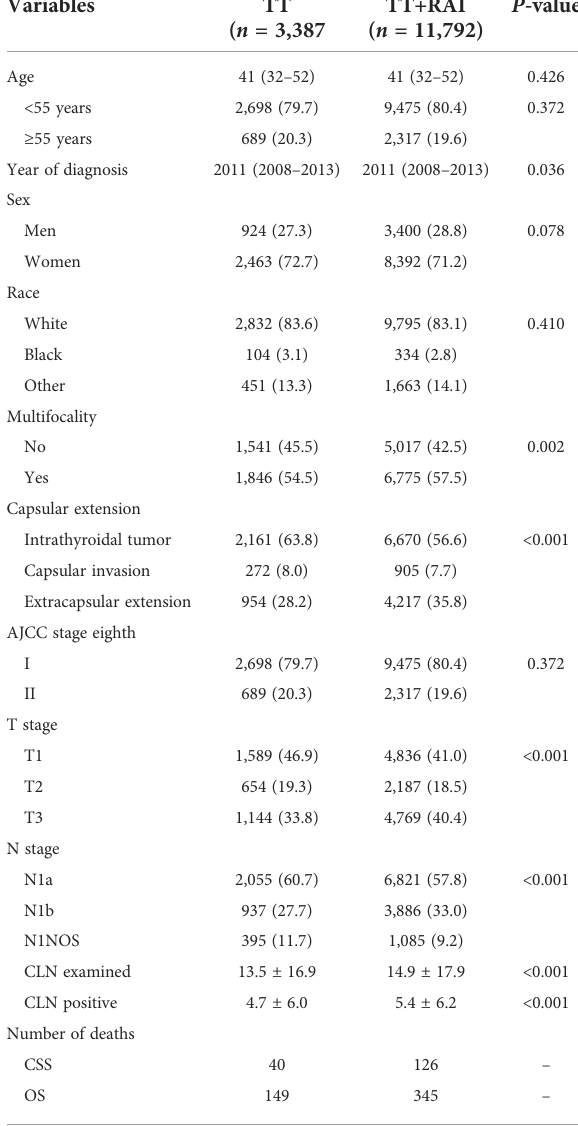
TABLE 1 Characteristics of the study population ( n =